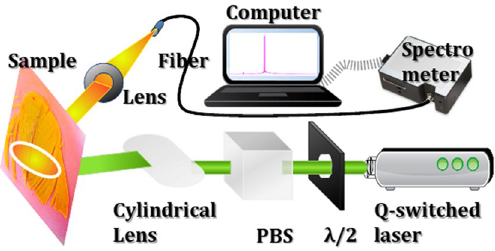
Figure 2. The illustration of the experimental setup and measurement of the random laser from parrot feathers.